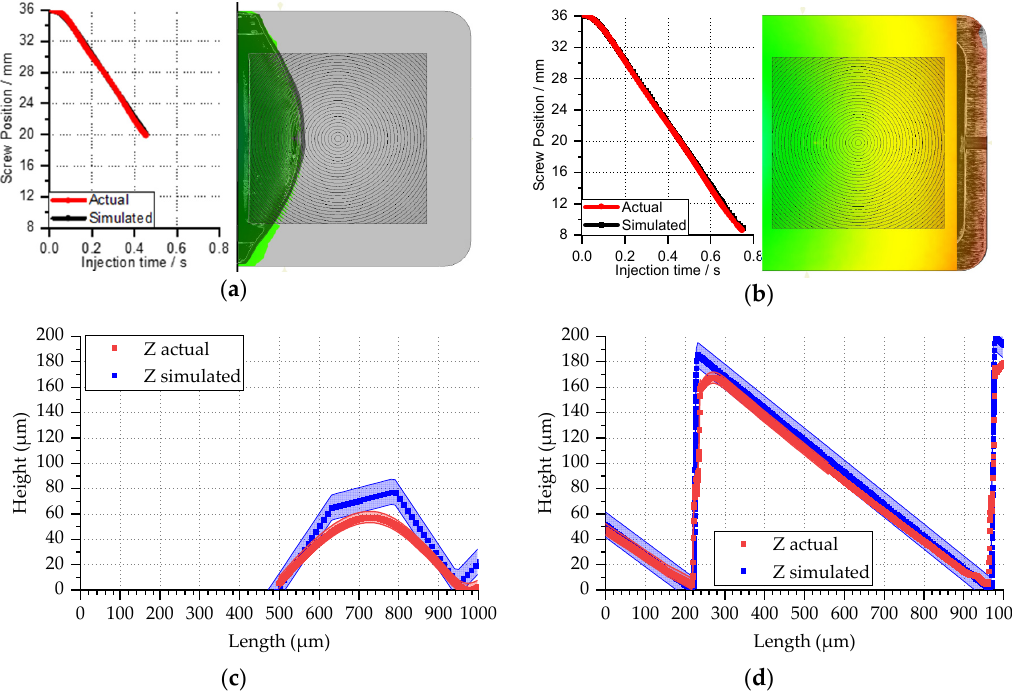
Figure 18. Filling volume comparison from the actual and simulated values for a short shot at meso- ( a ) and microscale ( c ), and full replication for the meso- ( b ) and microscale ( d ).